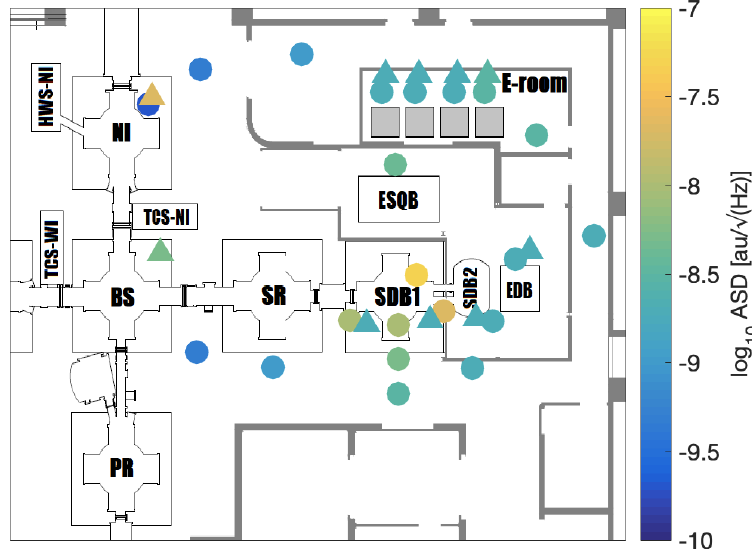
Figure 7. Near-field magnetic injection map. Positions of injection with the small coil are indicated, both for sinus excitation signals at 28 Hz (triangles) and at 368 Hz (circles). The marker color shade indicates the intensity of the induced excitation measured in the output port